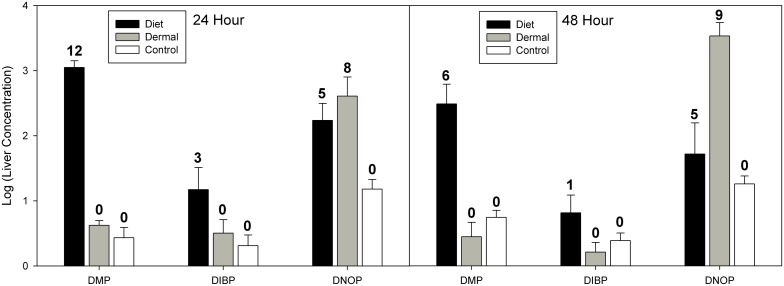
Phthalate concentrations in western fence lizard liver samples at 24 and 48 hour time points.Data for 24 hours and 48 hours are presented as log10 means (ng/g ± SE). Phthalate congeners are: di-methyl phthalate (DMP), di-iso-butyl phthalate (DIBP), and di-n-octyl phthalate (DNOP). Linear mixed effects model suggests significant effects of exposure route (χ2 = 31.18, df = 2, p<0.001) and phthalate congener (χ2 = 63.41, df = 2, p<0.001), and a marginally significant effect of time (χ2 = 3.58, df = 2, p = 0.059). See text for complete statistical information. Numbers above error bars indicate the number of detections out of 12 samples.